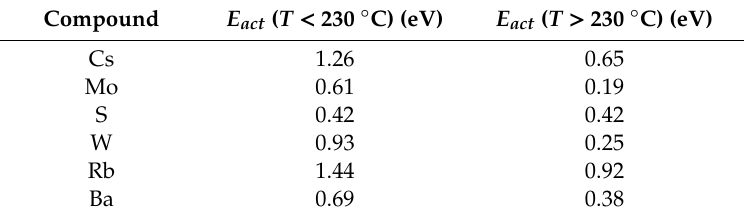
Table 2. Apparent activation energy values for the studied compounds at low ( T < 230 ◦ C) and high temperature ( T > 230 ◦ C).